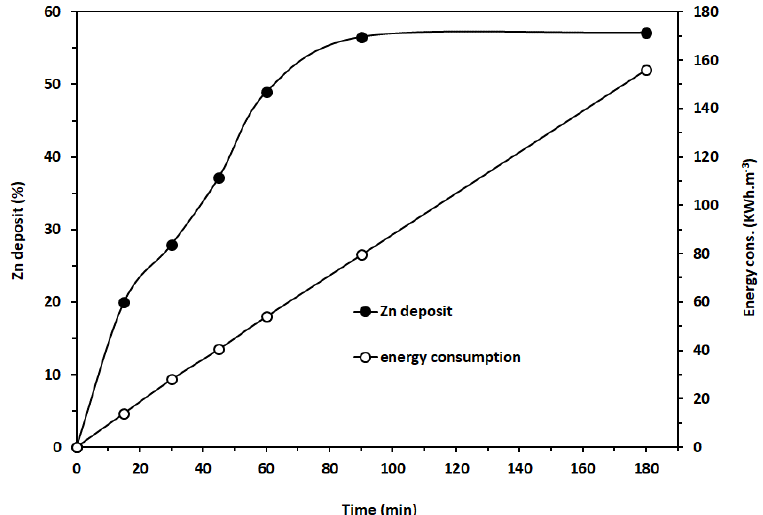
Figure 4. Variation in residual Zn concentration and effect of energy consumption as a function of time applying a current density of 500 A/m 2 .